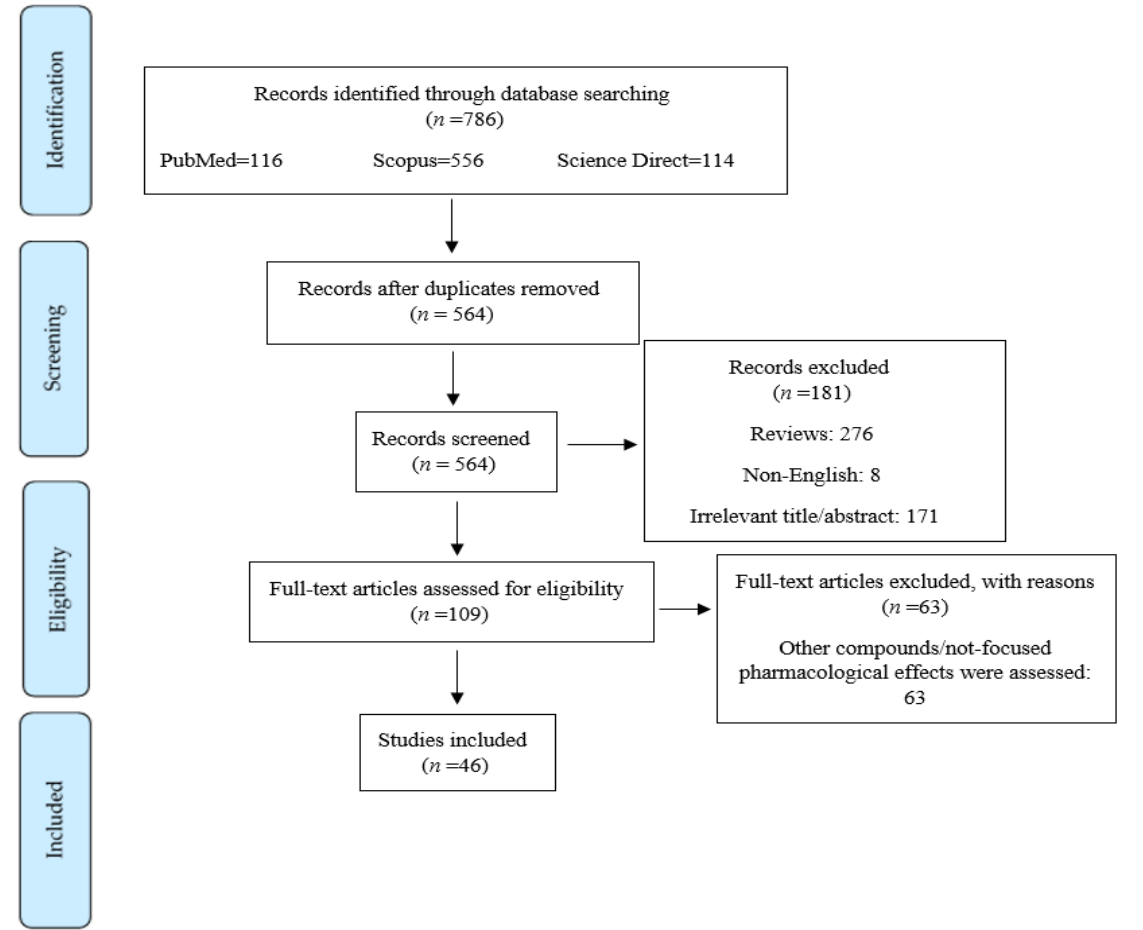
Figure 1. Flowchart of the process of literature search and selection of relevant reports.